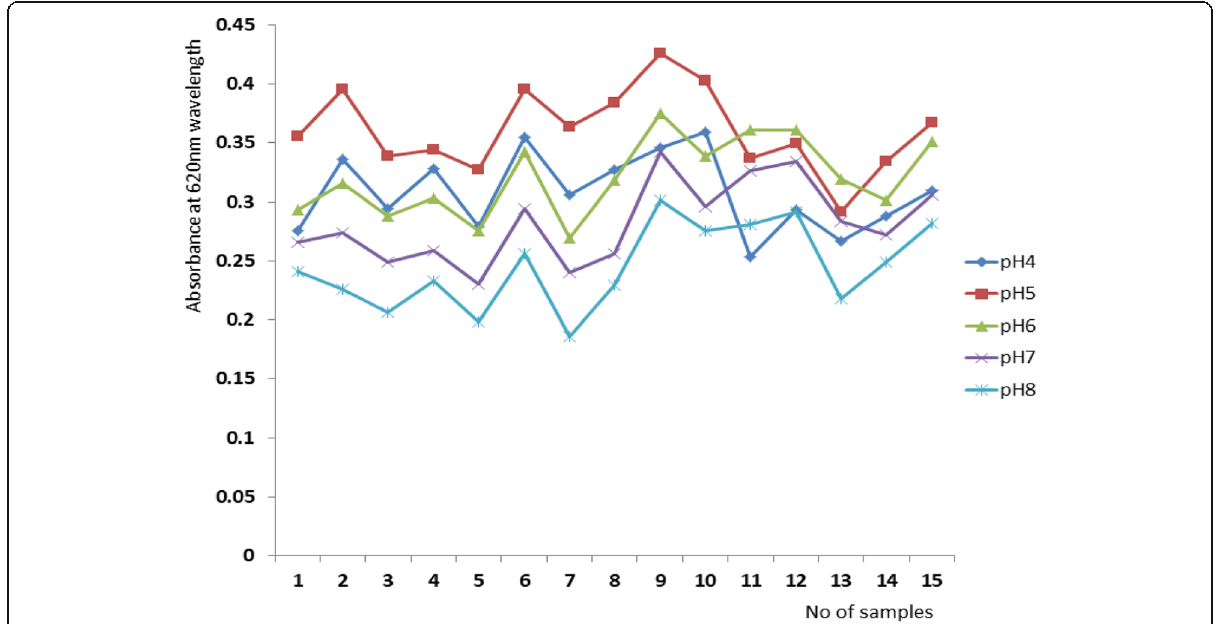
Fig. 2 Optimization assay for pH (absorbance at 620 nm